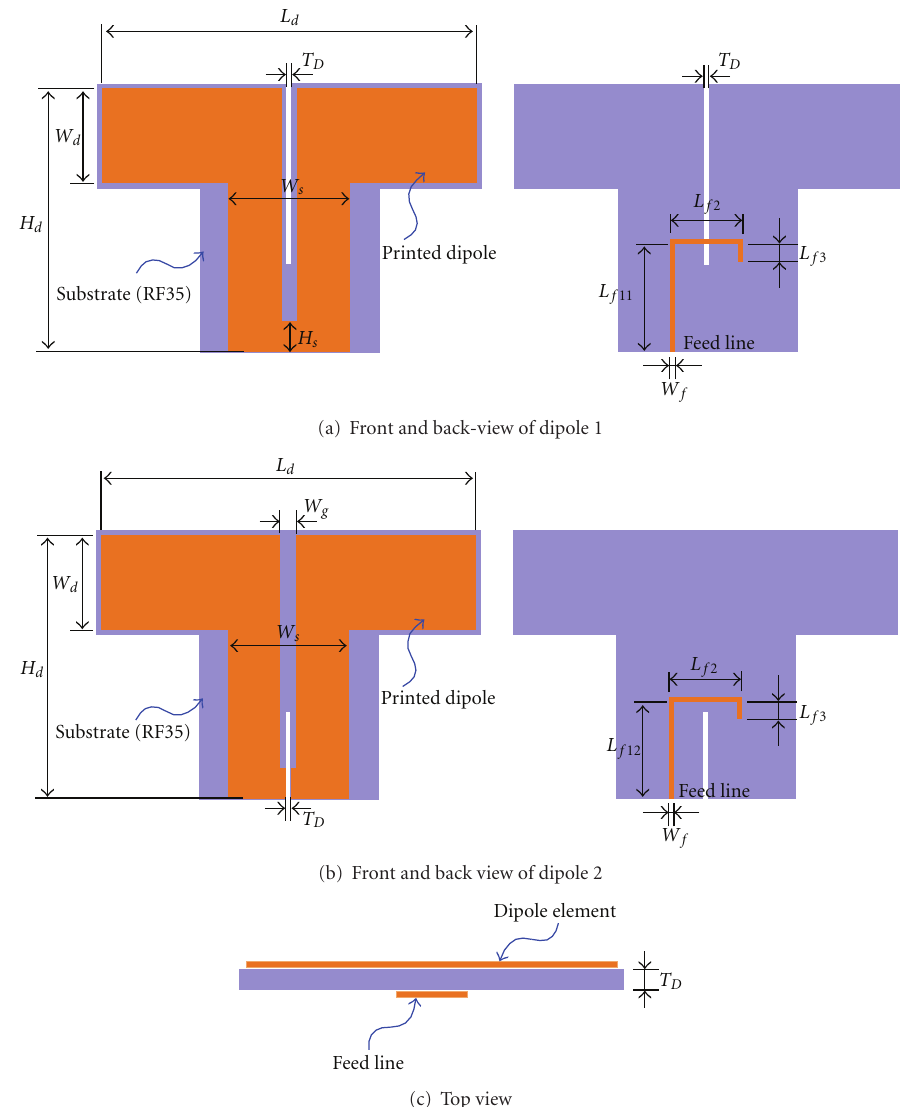
Figure 2: Design parameters of each printed dipole element ( T D = 0 . 76mm, W d = 17 . 50mm, L d = 84 . 00mm, H d = 49 . 50mm, W g = 3 . 00mm, W s = 26 . 00mm, H s = 6 . 00mm, W f = 1 . 00mm, L f 11 = 22 . 30mm, L f 12 = 20 . 30mm, L f 2 = 15 . 50mm, L f 3 = 5 . 00mm).